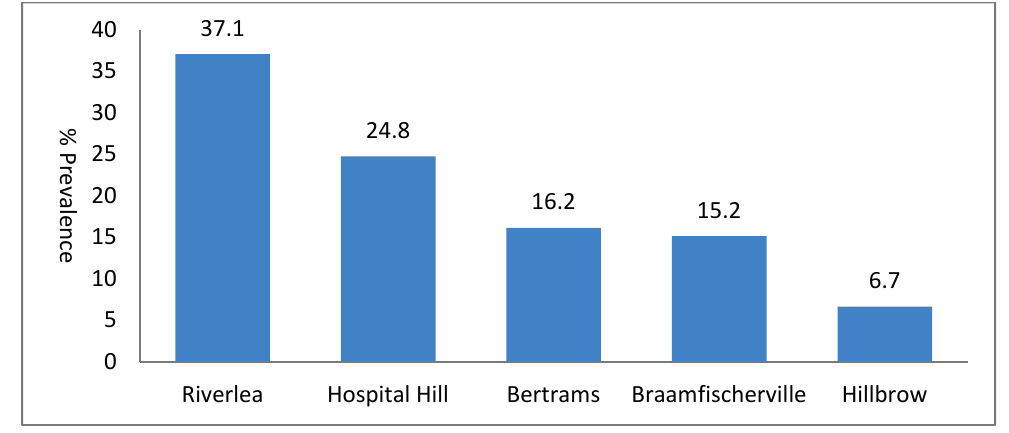
Figure 1. Overall prevalence of cottage industry in the five study